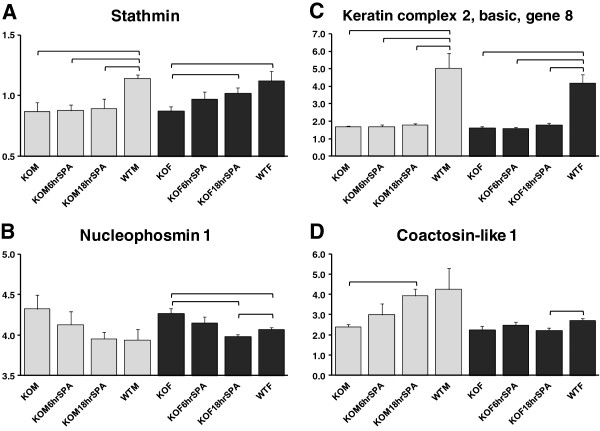
Examples of protein patterns. Graphs shown in Panels A-D indicate different SP-A-response patterns for: A) stathmin; B) nucleophosmin 1; C) keratin complex 2, basic, gene 8; and D) coactosin-like 1. Significant differences (p < 0.05) are indicated by brackets.